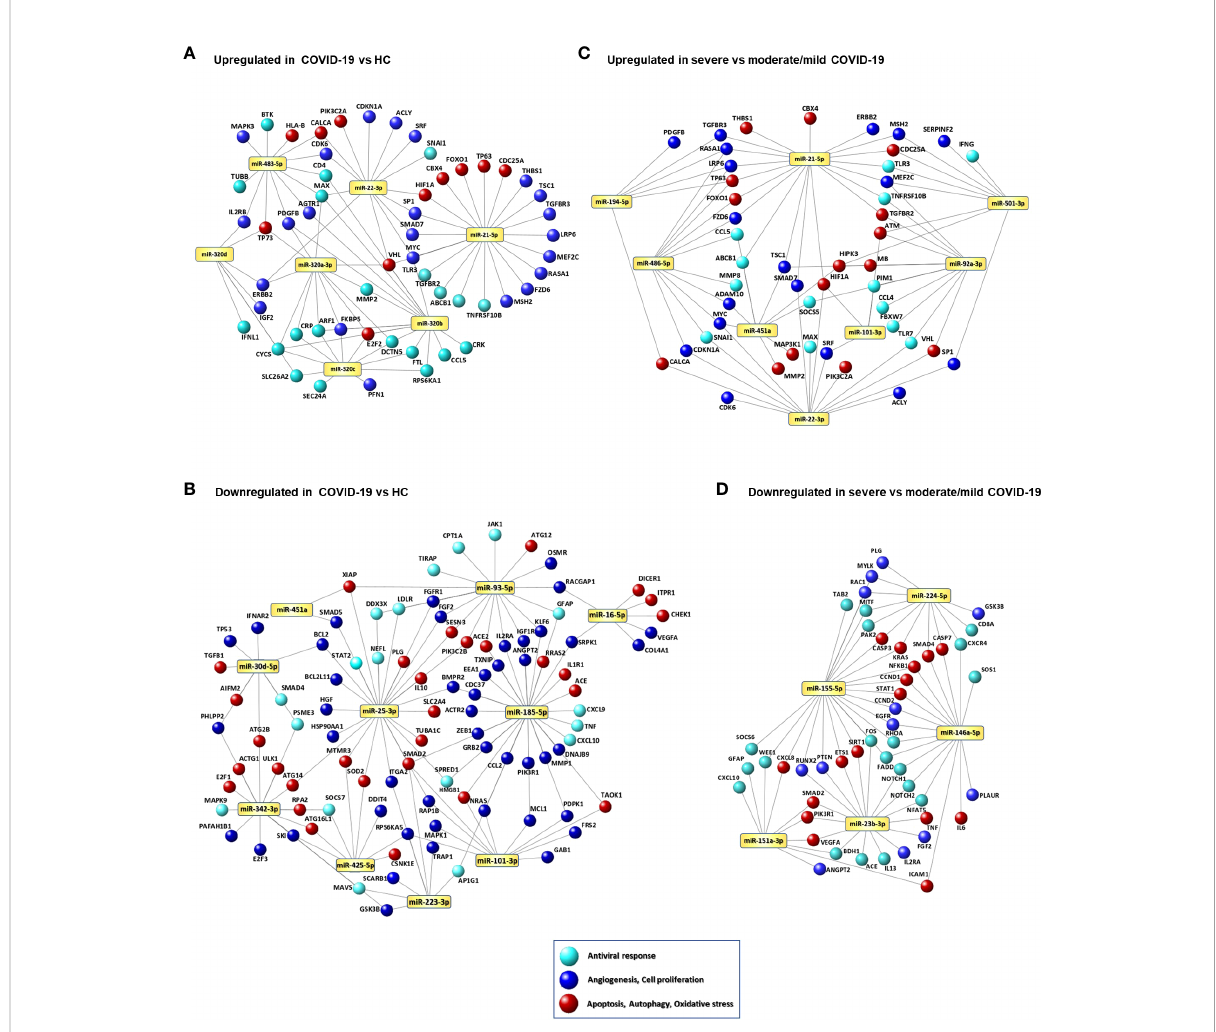
FIGURE 3 Signaling networks of COVID-19-associated serum miRNAs. Networks of putative target genes for circulating miRNAs that were signi fi cantly upregulated (A) and downregulated (B) in COVID-19 patients vs. healthy controls (HCs) and signi fi cantly upregulated (C) and downregulated (D) in patients with severe COVID-19 vs. patients with mild/moderate COVID-19. Methods for target gene identi fi cation and selection and network visualization are described in the Methods